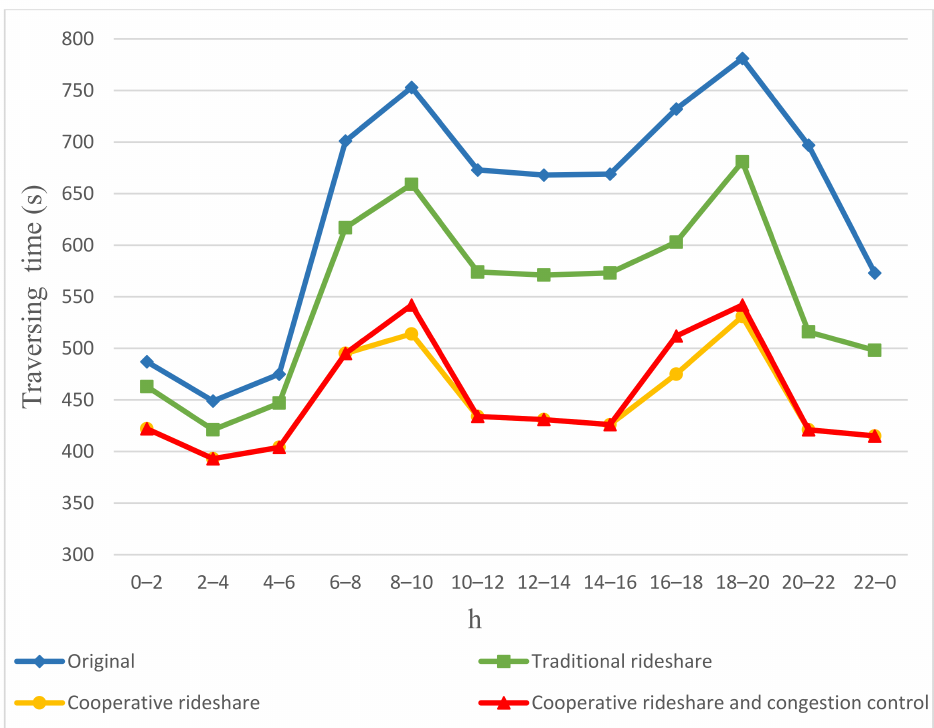
Figure 17. Traversing times of PEV/SAEV passengers on minor arterial 1.